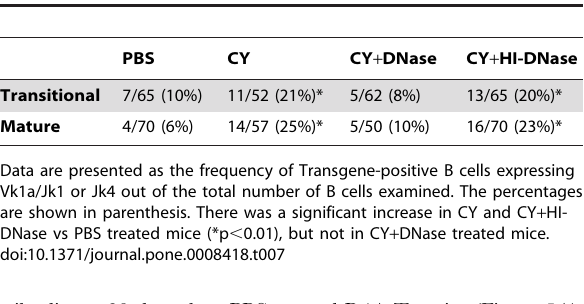
Table 7. Frequency of high affinity DNA-reactive B cells in R4A Tg mice treated with CY and